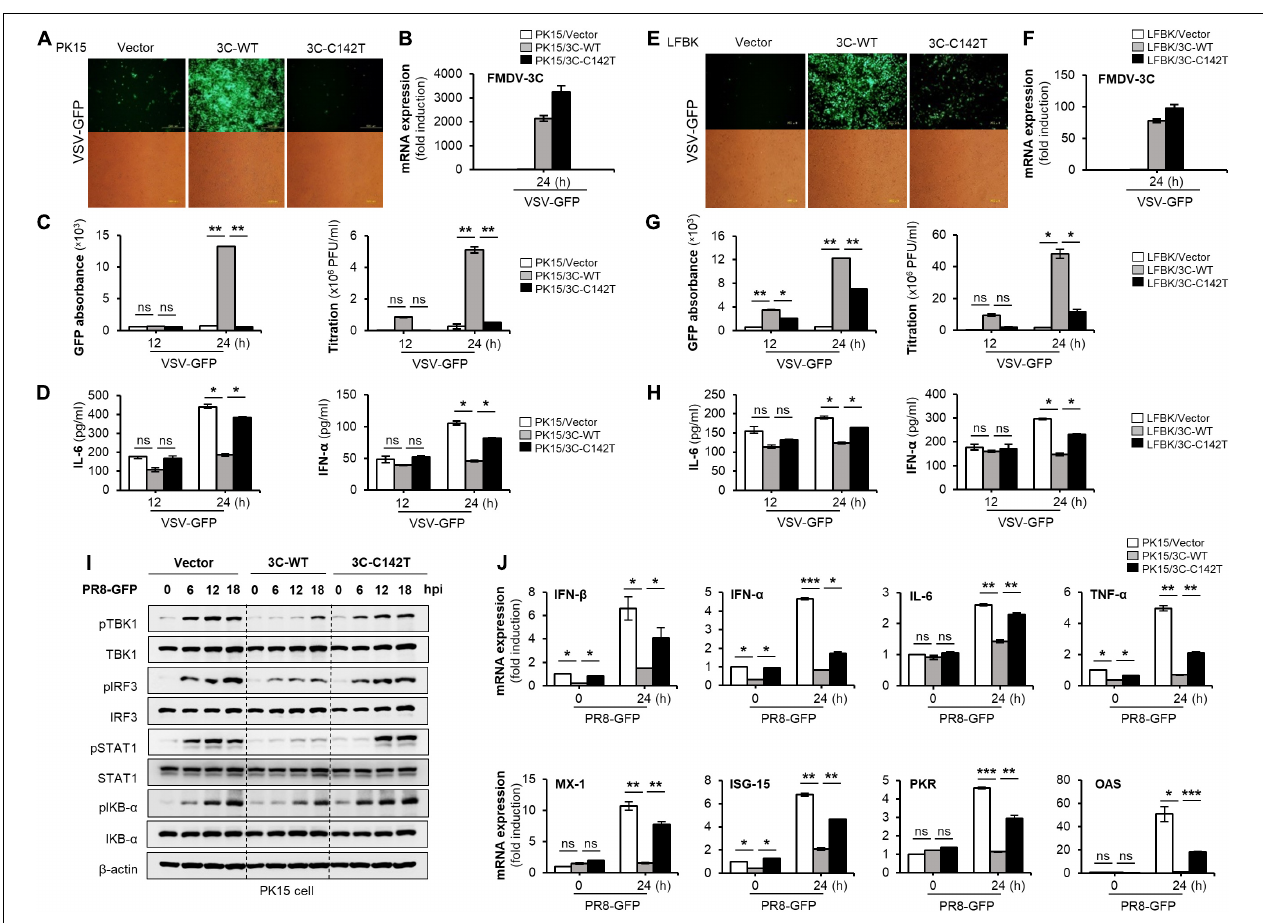
FIGURE 4 | FMDV 3C pro C142T is deficient in the negative regulation of type-I IFN signaling. The PK15 cells or LFBK cells were transiently transfected with wild-type FMDV 3C pro , 3C pro C142T, or control plasmid, following VSV-GFP (1 MOI) infection. (A,E) GFP expression, (B,F) wild-type FMDV 3C pro and 3C pro C142T expression by qRT-PCR, (C,G) GFP absorbance and virus titer, (D,H) IL-6 and IFN- α secretion was measured at indicated time points. (I) PK15 cells were transiently transfected with wild-type FMDV 3C pro , 3C pro C142T, or control plasmid and infected with PR8-GFP (3 MOI). Immunoblotting was performed with cells harvested at 0, 6, 12, and 18 hpi to detect phosphorylated (p-) TBK1, TBK1, p-IRF3, IRF3, p-STAT1, STAT1, p-I κ B- α , IkB- α , and β -actin. (J) PK15 cells were transiently transfected with wild-type FMDV 3C pro , 3C pro C142T, or control plasmid and PR8-GFP (3 MOI) infection, following total RNA extraction and qRT-PCR for respective antiviral genes